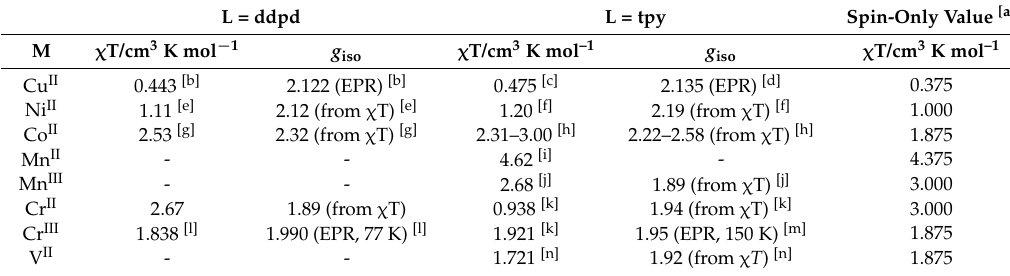
Table 5. Room temperature magnetic susceptibility and g iso data (from SQUID or EPR